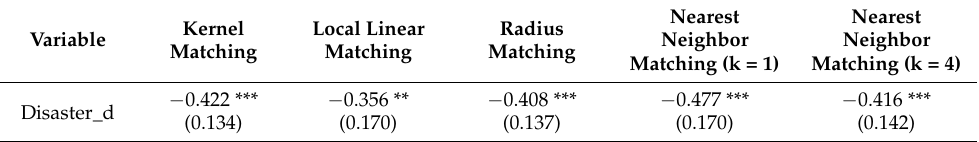
Table 5. PSM analysis of the effects of natural disasters on middle-aged and older adults’ mental health.